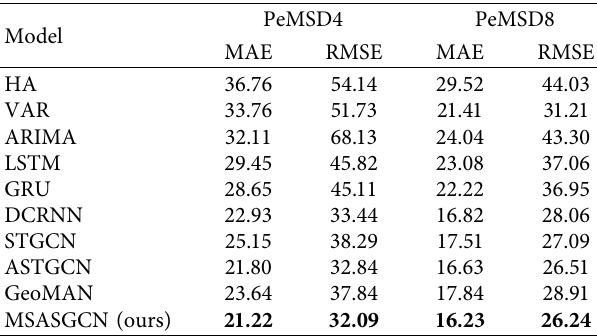
Table 2: Average performance comparison of future 1-hour traffic flow prediction